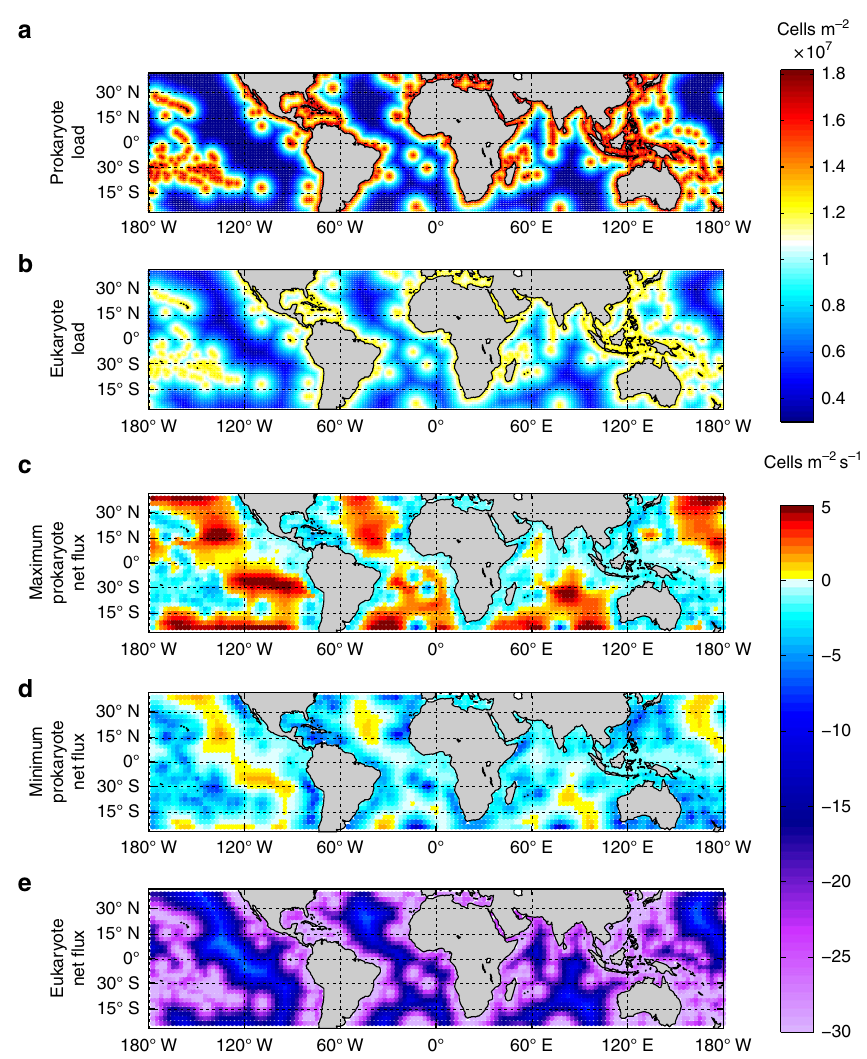
Figure 4 Microbial loads and air-sea exchange fl uxes over the global tropical and subtropical ocean. Prokaryotic load a and eukaryotic load b over the ocean extension compressed between 40° S and 40° N with resolution of 1° × 1°; maximum net fl uxes of prokaryotes considering high spray fl uxes c and low spray fl uxes d ; and net fl uxes of eukaryotes e considering high spray fl uxes (the differences between net fl uxes of eukaryotes using high or low spray fl uxes were negligible) with resolution of 2.5° × 2.5°. Negative values indicate net deposition fl uxes Methods Collection of airborne microbes . Air sampling was carried out using a com- Study area . Samples of airborne microbes were collected along the Malaspina mercially available cyclonic collector ( Coriolis- Δ , Bertin Technologies 36 ) placed at bow-side at ~10m height over sea level at the top deck of the R/V Hespérides . The 2010 Circumnavigation Expedition 34 on board the R/V Hespérides from December collector was operated using the procedures described earlier 2 . Brie fl y, air was 2010 to July 2011 collecting samples over 118 locations across the Atlantic, drawn into the sampler at 300 lmin − 1 for 6 h (equivalent to 108 m 3 ), and the Paci fi c and Indian Oceans (Supplementary Fig. 1). According to the atmospheric collection liquid was re fi lled continuously by the system at a rate suf fi cient to circulation of the study area, characterised using atmospheric monthly fi eld data match the loss of liquid by evaporation and re-aerosolisation measured during a obtained from the NCEP/NCAR atmospheric reanalysis 35 , most samples were previous 10min run. Daily, a fi eld blank was collected by sampling air for 2min taken near the Inter Tropical Convergence Zone (ITCZ) where the winds are (equivalent to 0.6 m 3 ). Samples were processed immediately after collection and the relatively weak and typically prevailing from the east. The trade winds converging volume was adjusted to 15 ml with additional collection liquid if necessary. along the ITCZ come from NE in the Northern Hemisphere and from SE in the Southern Hemisphere. The position of the ITCZ (around the equator) migrates from the Southern to the Northern Hemisphere between January and July over the Indian and Paci fi c Oceans but it does not signi fi cantly change in the Microbial abundance and biomass . Prokaryotes and unicellular eukaryotes were Atlantic Ocean during the same period of time. The North Atlantic region is counted in 5ml aliquots of the air samples by epi fl uorescence microscopy ( Leika characterised by the presence of strong northeasterly winds, enhancing the DM 1000) following the procedures outlined in Mayol et al. 2 . The fraction of transport of biological particles across the Atlantic from Europe. When the protists from total eukaryotic counts was determined using the blue excitation light South Atlantic region was sampled (February 2011) the wind direction was at 480 nm, which allows the detection of chlorophyll pigments as a red-colour mainly from SE, and from NE close to Equator, indicating that the ITCZ was particle in autotrophic protists. Heterotrophic protists were expected to be in crossed during sampling. The West Paci fi c Region was characterised by weak similar quantities than those of autotrophic protists, assuming that they are in a winds from the South, while in the Central Paci fi c Region stronger winds were similar proportion in seawater. Thus, fungal spores were expected to be the from the East. In summer, the East Paci fi c Region was characterised by remaining fraction. A minimum of 150 prokaryotes and unicellular eukaryotes moderate winds from NE and by weak southerly winds close to Central were counted per sample in at least 12 different fi elds, or a minimum of 150 America. However, during winter season the winds were slightly stronger and fi elds were counted for samples with lower abundances. Microbial losses by were coming from NE. The Indian Region was in fl uenced by the trade winds at re-aerosolisation were corrected as described earlier 2 . the North and by the strong westerly winds at the South. NATURE COMMUNICATIONS | 8: 201 | DOI: 10.1038/s41467-017-00110-9 |